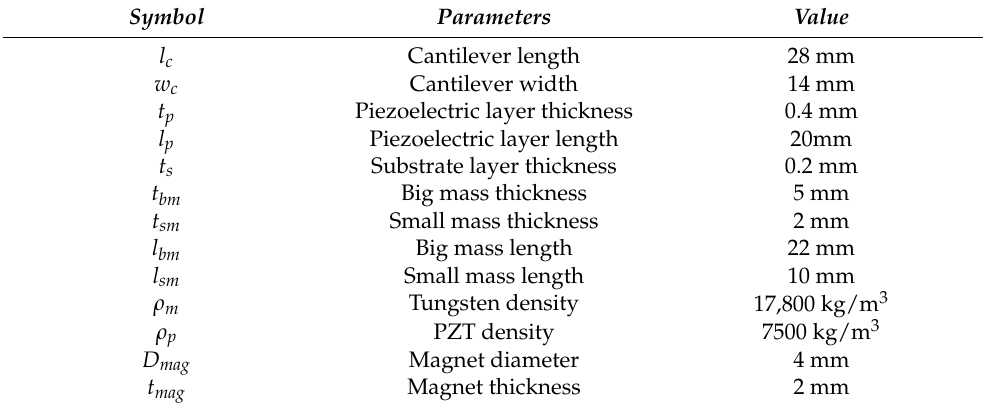
Table 1. PVEH design